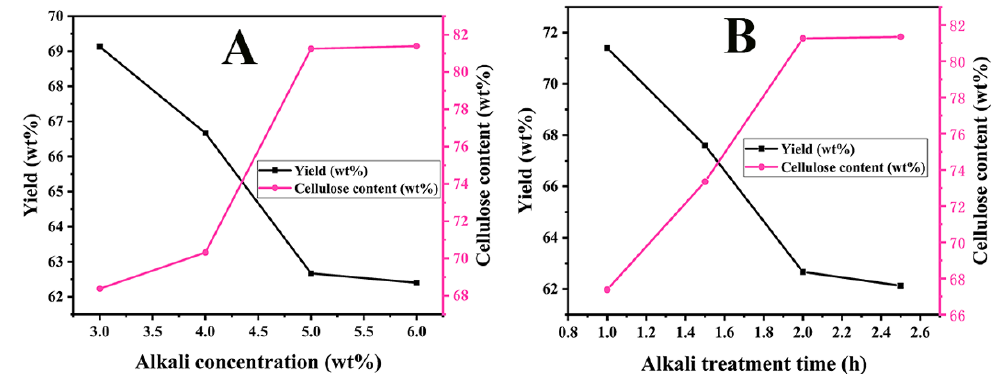
Figure 3. Optimization of the dilute alkali treatment process: ( A ) alkali concentration, ( B ) alkali treatment time.